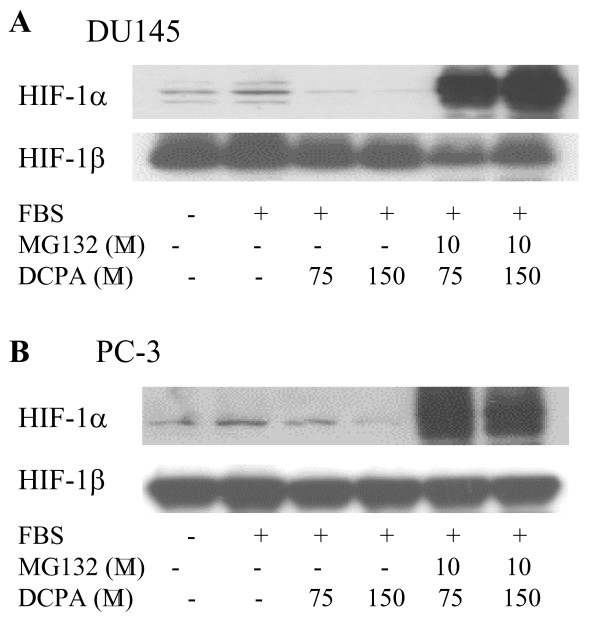
MG132 treatment prevented the inhibition of HIF-1α expression by DCPA. DU145 (A) and PC-3 (B) cells were cultured in serum-free MEM basal medium with Earle's salt in the presence of 0, 75, or 150 μM DCPA for 24 h, followed by the treatment with or without 10 μM of MG132 for 30 min. Cells were incubated with or without 10% fetal bovine serum for 6 h. Total cellular protein extracts were prepared from these cells, and aliquots of the extracts (30 μg) were used for the immunoblotting analysis using antibodies against HIF-1α and HIF-1β.